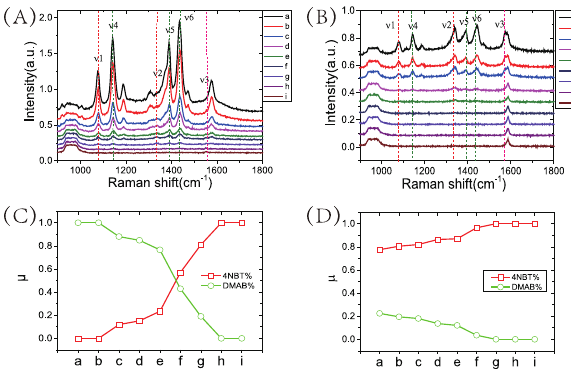
Figure 3: (A) Surface-enhanced Raman scattering (SERS) spectrum of 4-nitrobenzenethiol (4NBT) in the single-layer graphene (SLG)- coupled nanowire (NW) hybrid plasmonic gap by oblique incidence with θ = 30 ° at difference points away from the center of axis of the NW with 532 nm wavelength excitation. (B) SERS spectrum of 4NBT in the graphene-coupled NW hybrid plasmonic gap by normal inci- dence with θ = 90 ° at difference points away from the center of axis of the NW with 532 nm wavelength excitation. (C) Coverage of the 4NBT reactant and the p , p ′ -dimercaptoazobenzene (DMAB) product at difference points in A; (D) Coverage of the 4NBT reactant and the DMAB product at difference points in